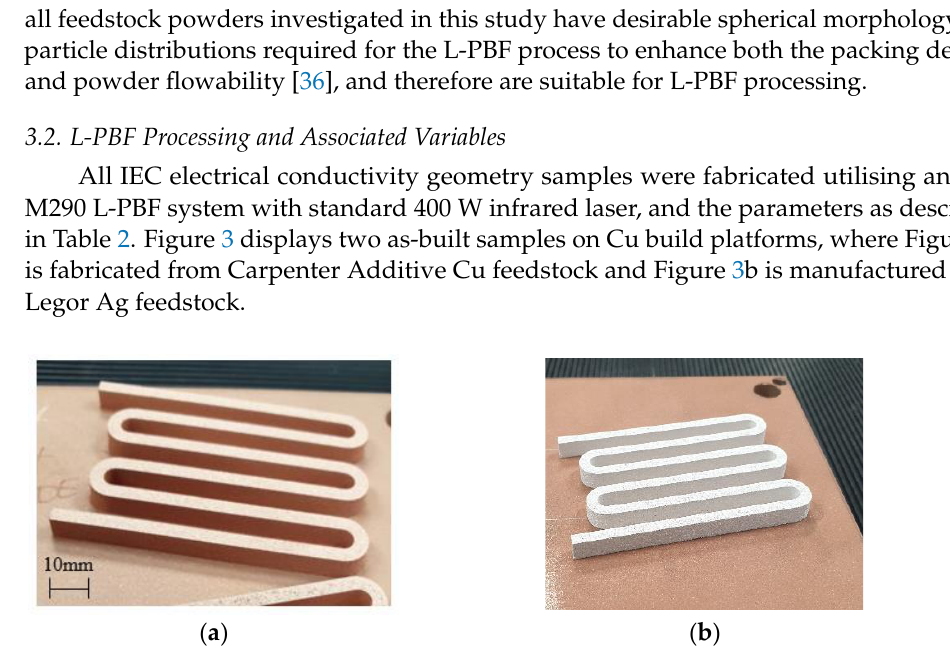
Figure 3. High-purity copper and silver IEC electrical conductivity geometry samples as built on copper substrates, where ( a ) is Carpenter Additive Cu and ( b ) is Legor Ag.